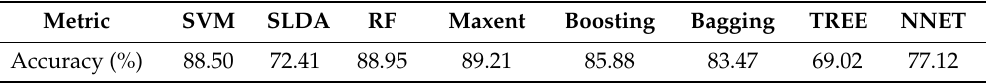
Table 1. Classification accuracy for each machine learning (ML) algorithm using 10-fold cross validation. SVM—support vector machine, SLDA—scaled linear discriminant analysis, RF—random forest, TREE—classification tree, NNET—neural